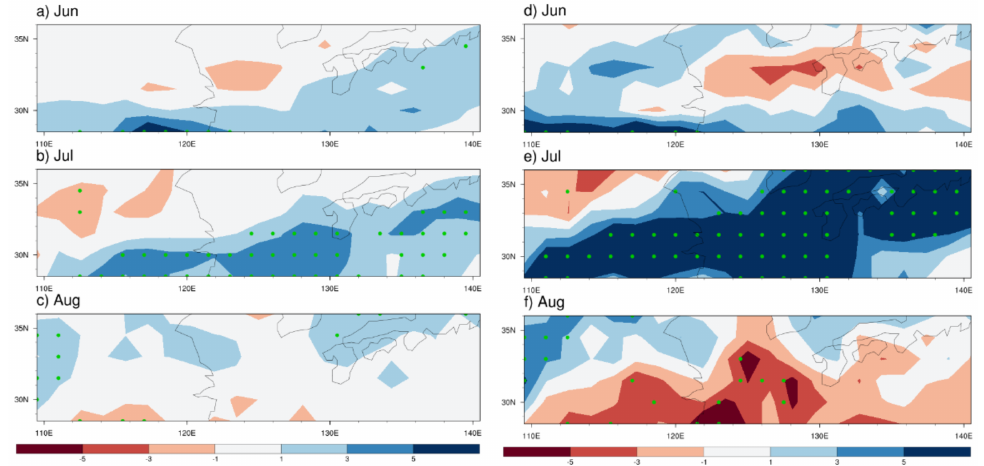
Figure 12. Regression maps of precipitation onto spring Nino 3 (5 ◦ S–5 ◦ N, 150 ◦ W–90 ◦ W) index ( a – c ) and summer North Indian Ocean to South China Sea SSTAs (0–20 ◦ N,70–120 ◦ E) ( d – f ). Stippled areas indicate anomalies that exceed the 90% confidence levels. Units: